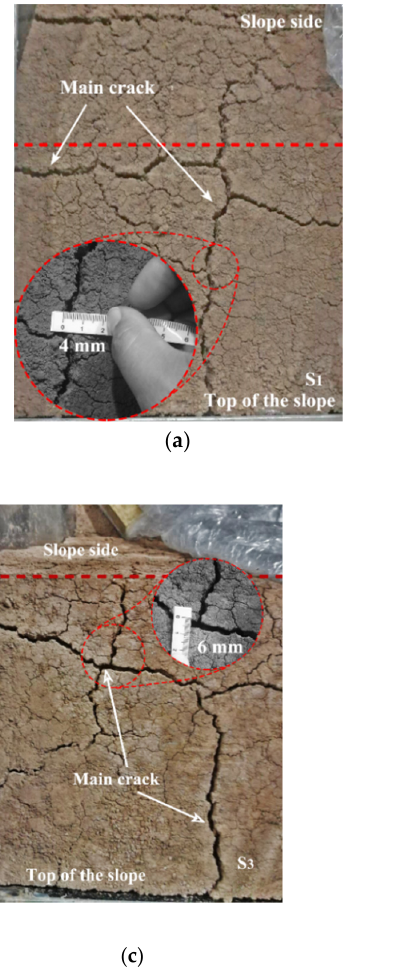
Figure 6. Crack development of the slope model after four freeze–thaw cycles ( a ) S 1 ( b ) S 2 ( c ) S 3 ( d ) Vertical cracks.